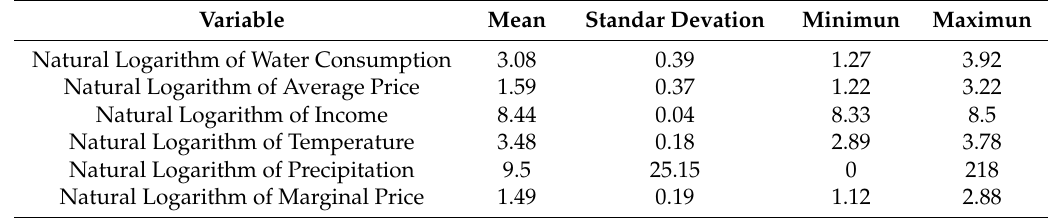
Table 2. Descriptive statistics of variables selected for the regression